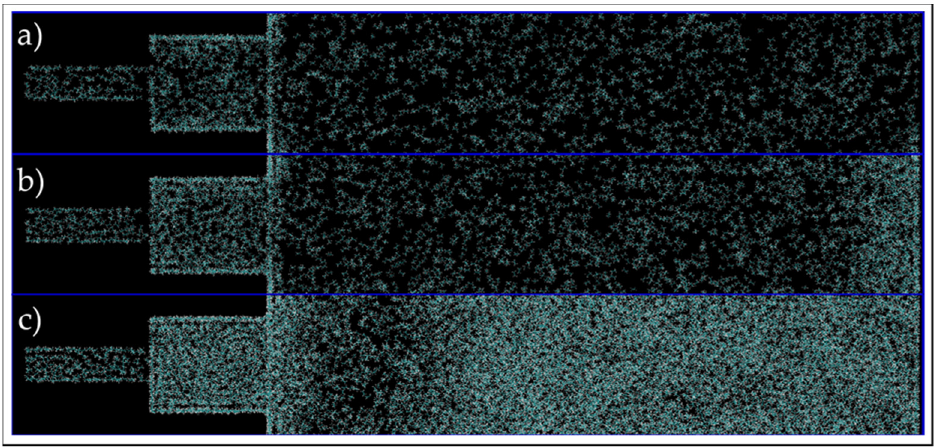
Figure 16. End of run images of the connected pore and bulk phase box, in C1 ( a ), C2 ( b ) and C3 ( c ) conditions simulations. Cyan and white colors represent carbon and hydrogen atoms, respectively.